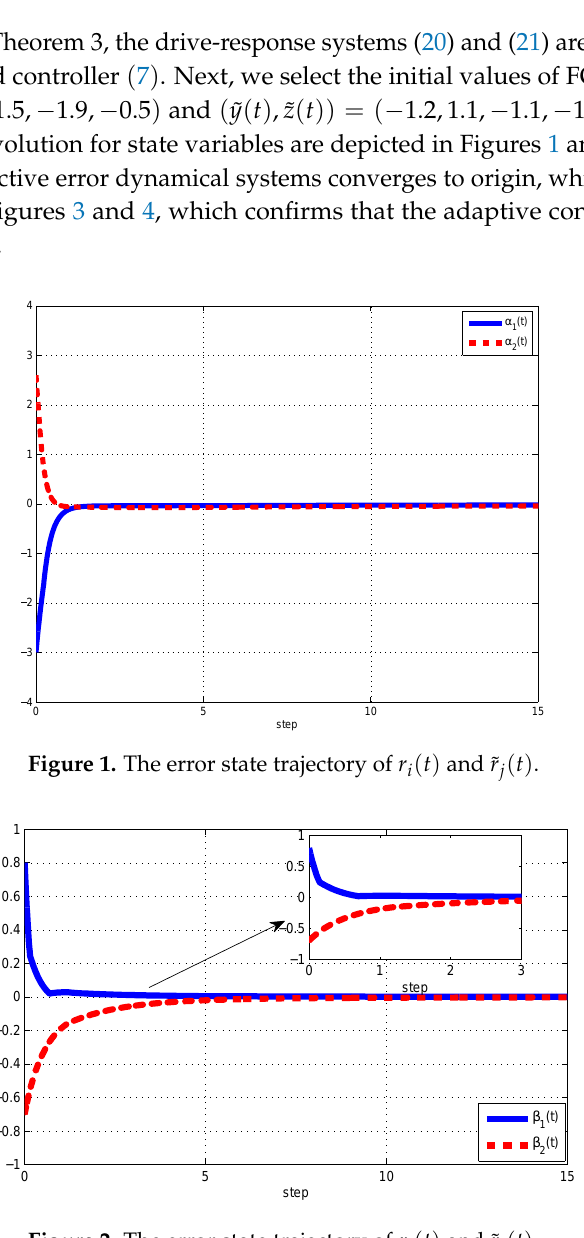
Figure 2. The error state trajectory of r i ( t ) and ˜ r j ( t )